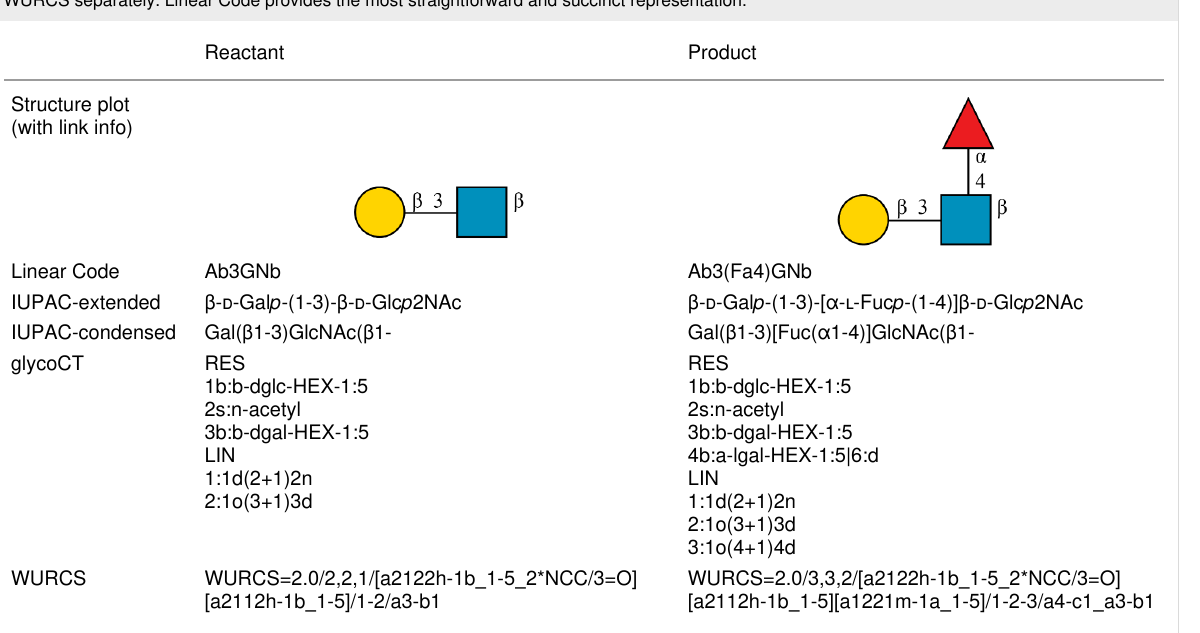
Table 1: The reaction rule Ab3GNb → Ab3(Fa4)GNb represented in Symbol Nomenclature for Glycans [18], Linear Code, IUPAC, GlycoCT, and WURCS separately. Linear Code provides the most straightforward and succinct